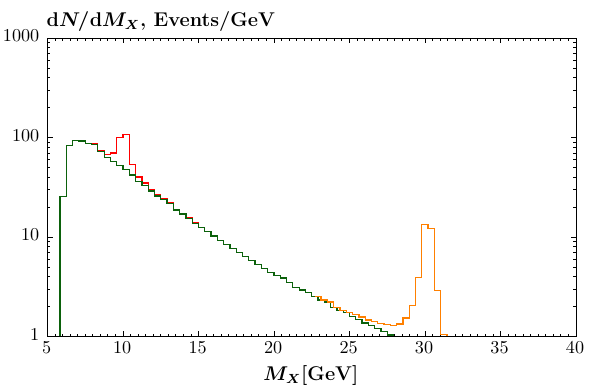
√ Fig. 8 Diphoton invariant mass distribution at s = 5 . 02 TeV in Pb– Pb collisions, for integrated luminosity L = 10nb − 1 . The result due to the production of an ALP of mass 10 and 30 GeV is shown, with coupling g a = 5 × 10 − 5 GeV − 1 , in both cases with a width of 0 . 5 GeV included to roughly mimic the effect of experimental resolution. The continuum light-by-light background is also shown. The photons are γ > 3GeVandpseudorapidity requiredtohavetransversemomentum p ⊥ | η γ | < 2 . 4. The ALP is assumed here only to couple to